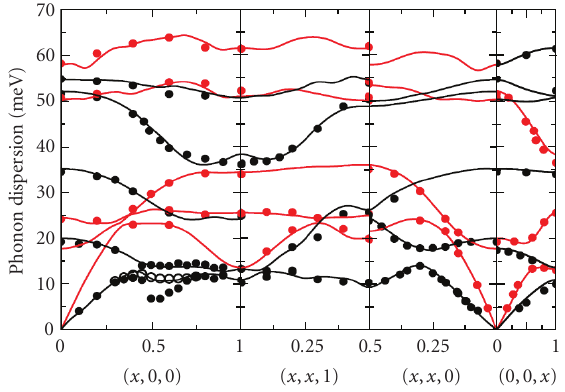
Figure 4: Calculated (lines) and observed (filled dots) phonon frequencies in YNi 2 B 2 C at 20K. Open dots along [100] were measured at 300 K. Branches shown in red/black refer to phonons of predominantly longitudinal/transverse polarization respectively. The horizontal axes denote di ff erent crystallographic directions in reciprocal lattice units (r.l.u.). The theoretical results were scaled up by a factor of 1.03 (from